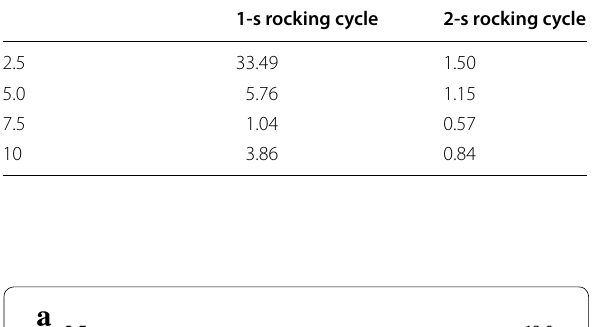
Table 1 k a at different culture depths and rocking cycles L in small-scale horizontal PBR Culture depth (cm)